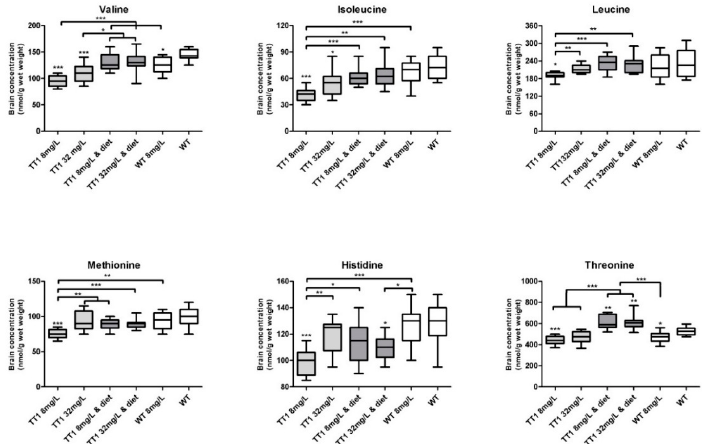
Figure 3. Brain concentrations of the non-phenylalanine, tyrosine and tryptophan LNAA. Untransformed data are expressed as boxplots (min–max whiskers). Numbers of mice are n = 13 or n = 14 for all treatment groups. * p < 0.05, ** p < 0.01 and *** p < 0.001 (two-sided).